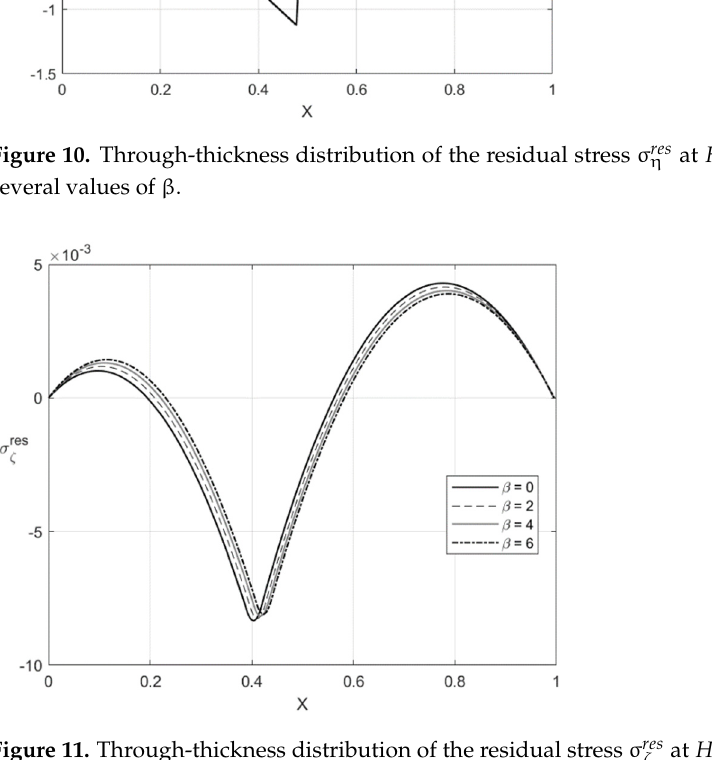
Figure 11. Through-thickness distribution of the residual stress σ res ζ at H / r CD = 0.06, f = 0.2, and several values of β .